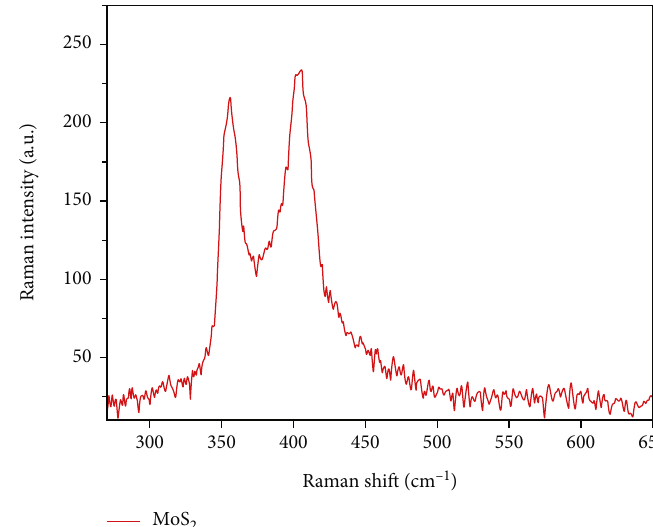
Figure 3: Raman spectra of the synthesized MoS